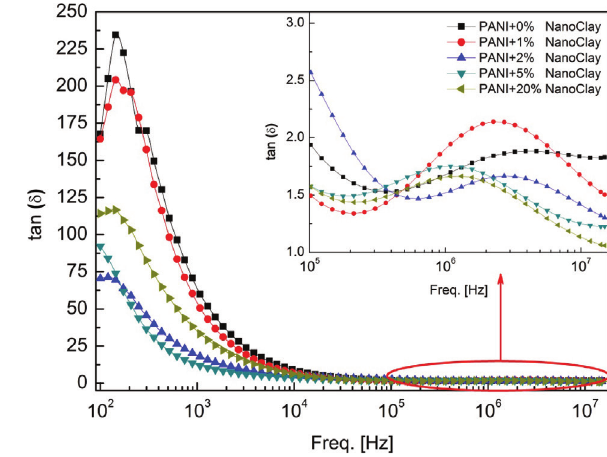
Fig. 4: Frequency dependency of the real part of dielectric constant of PANI + NC.